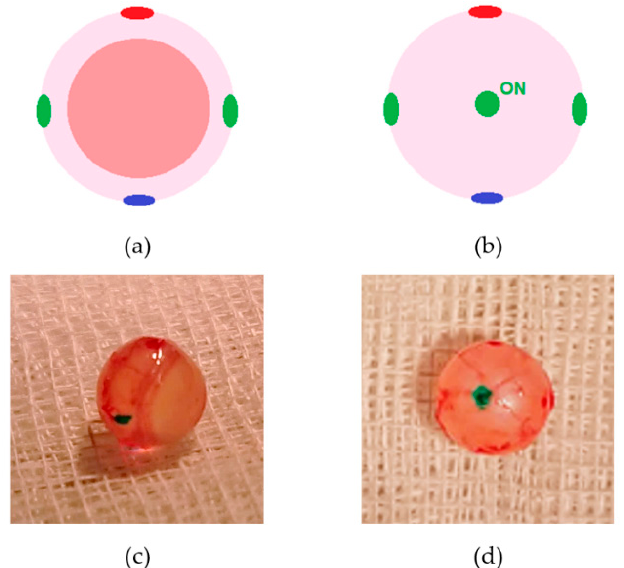
Figure 11. Representation of a rat ocular globe painted with tissue dyes: ( a ) frontal view; ( b ) caudal view. Photographs of a rat ocular globe painted with tissue dyes: ( c ) lateral view; ( d ) caudal view. In green we can identify the transected optic nerve. ON, optic nerve (previously published by our group in Silva et al., 2022